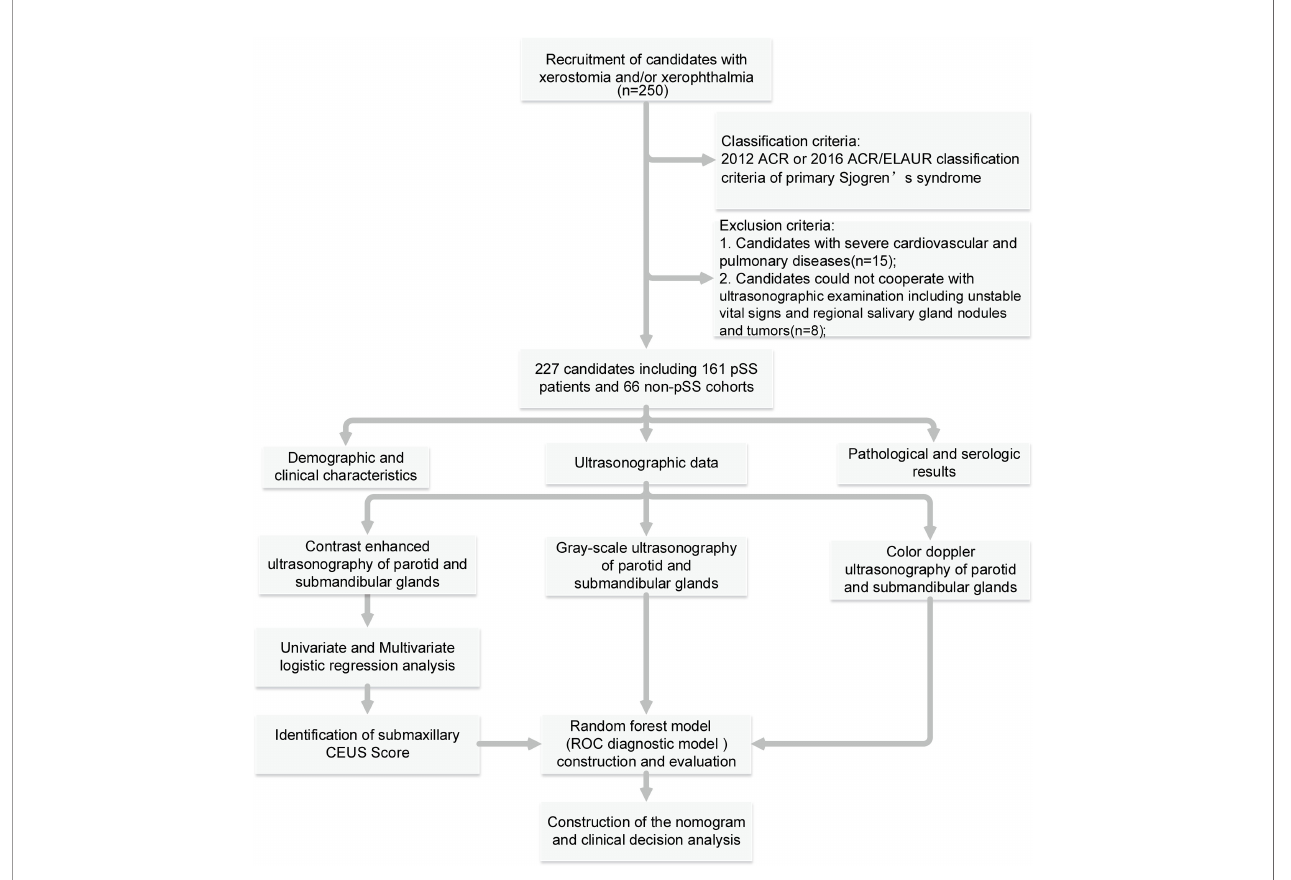
FIGURE 1 | Summary and description of the study work fl ow.